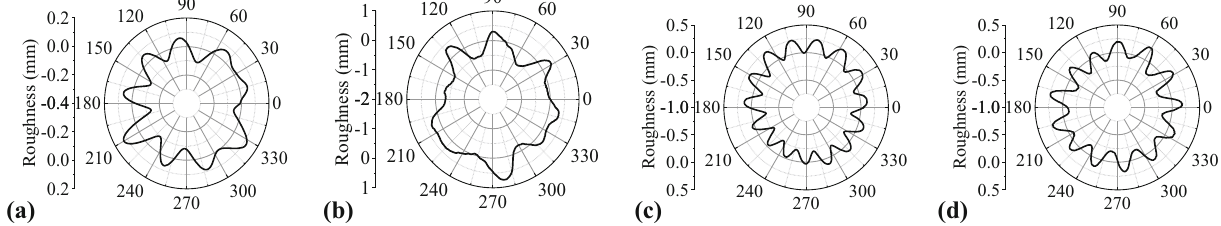
Fig. 2 Typical measurement results of polygonal wear of metro train wheels in China are described in polar coordinates: a LIM metro train with a maximum operating speed of 90 km/h; b type-B metro train with a maximum operating speed of 80 km/h; c type-A metro train with a maximum operating speed of 80 km/h; and d type-B metro train with a maximum operating speed of 120 km/h. The nominal wheel diameters of the LIM metro train and the other three types of metro trains are 730 mm and 840 mm,